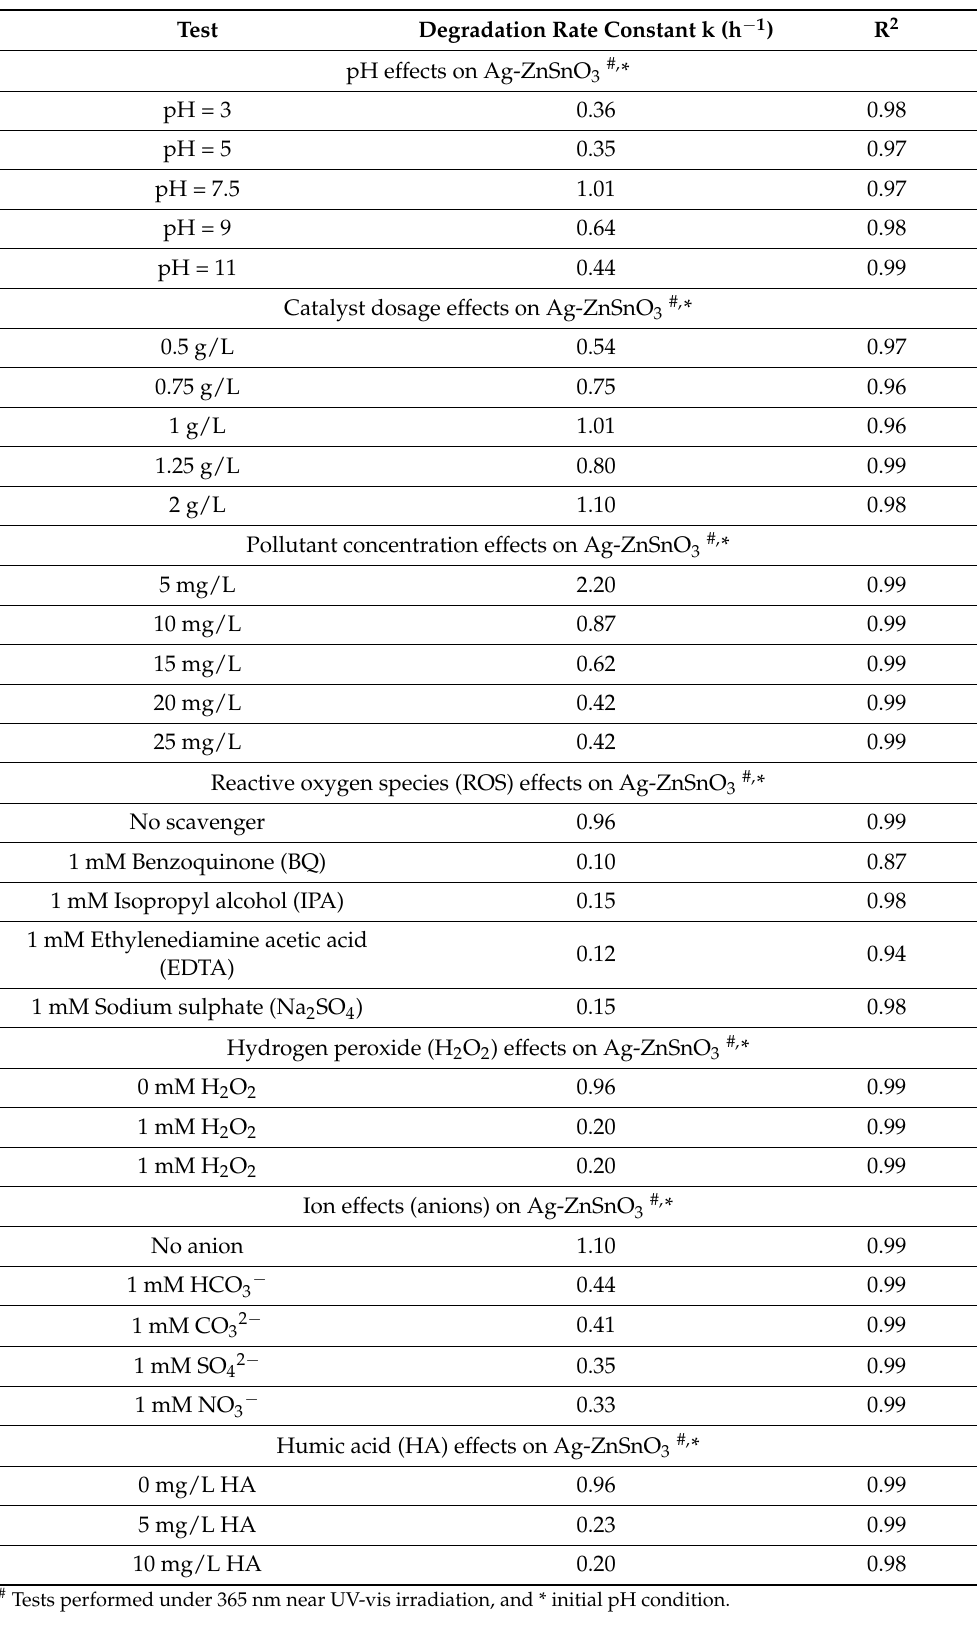
Table 4. Degradation rate constant k (h − 1 ) and associated correlation factor (R 2 ) values of controlled photocatalytic